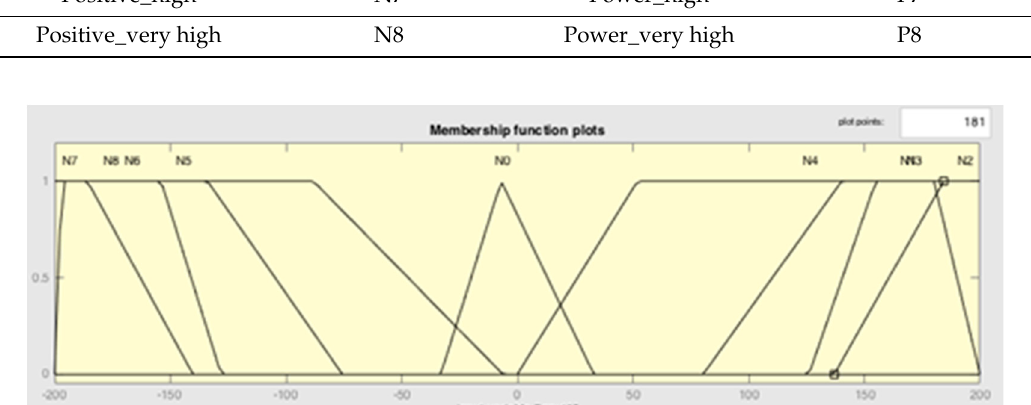
Figure A3. Trapezoidal pH input functions.